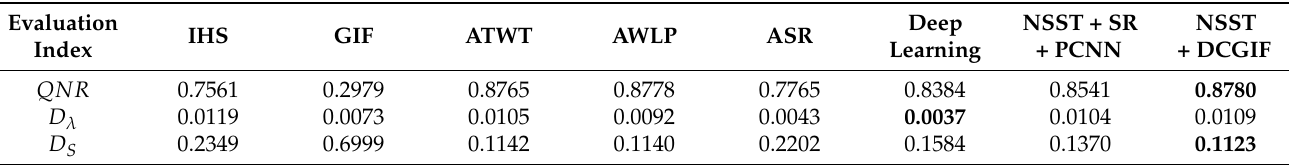
Table 5. Objective evaluation of real data.